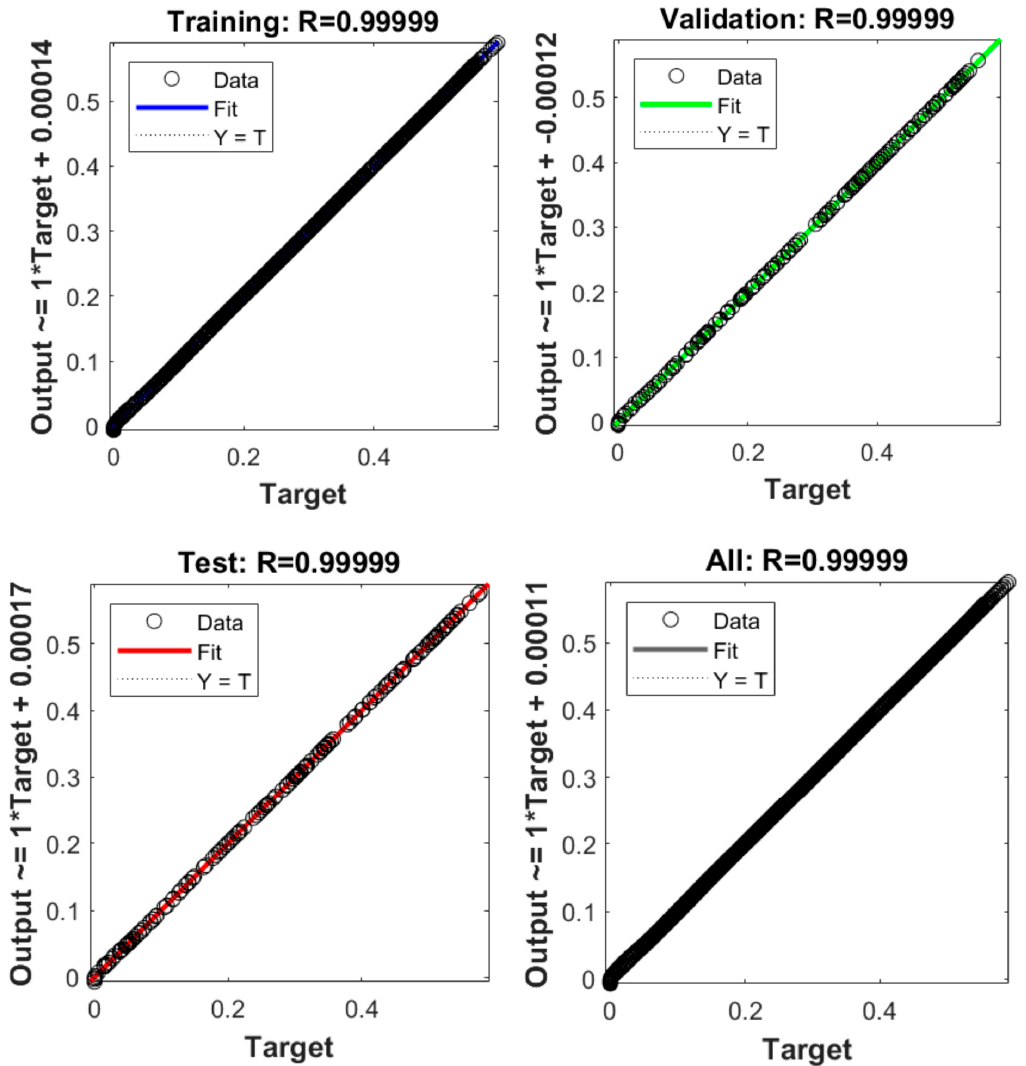
Figure 15. Regression reports for the training, validation, test, and all data. The R -value for each case is reported above each subfigure.